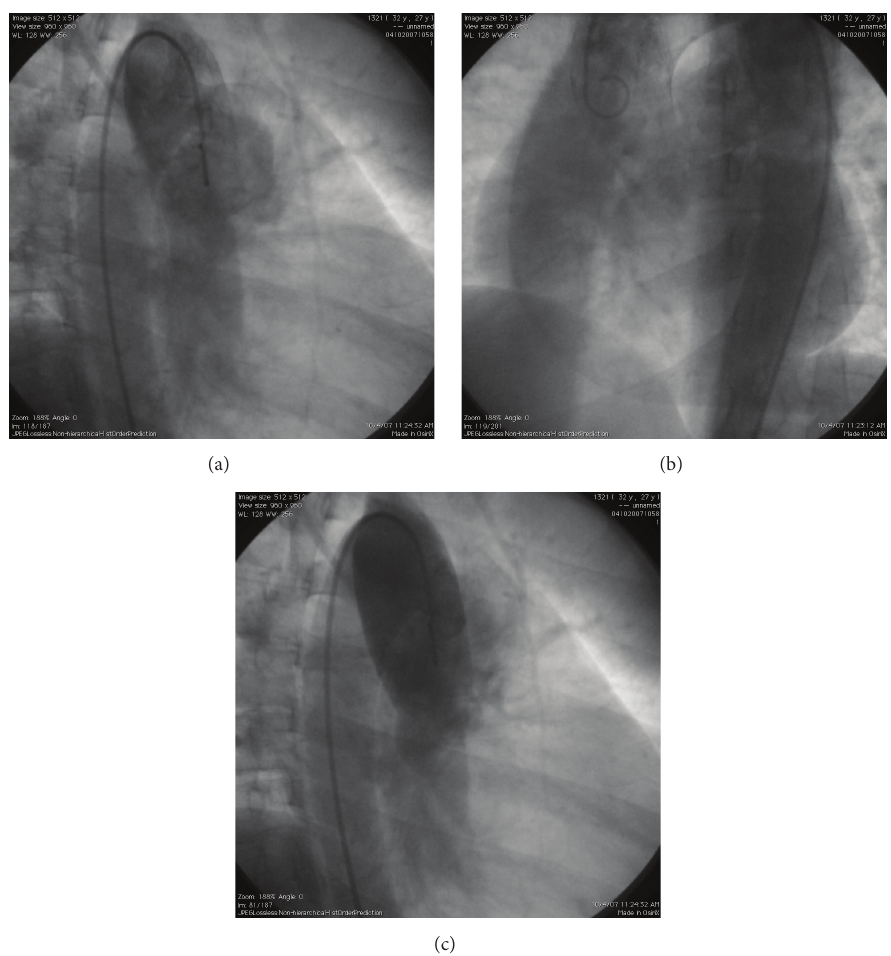
Figure 2: Aortic root injections,